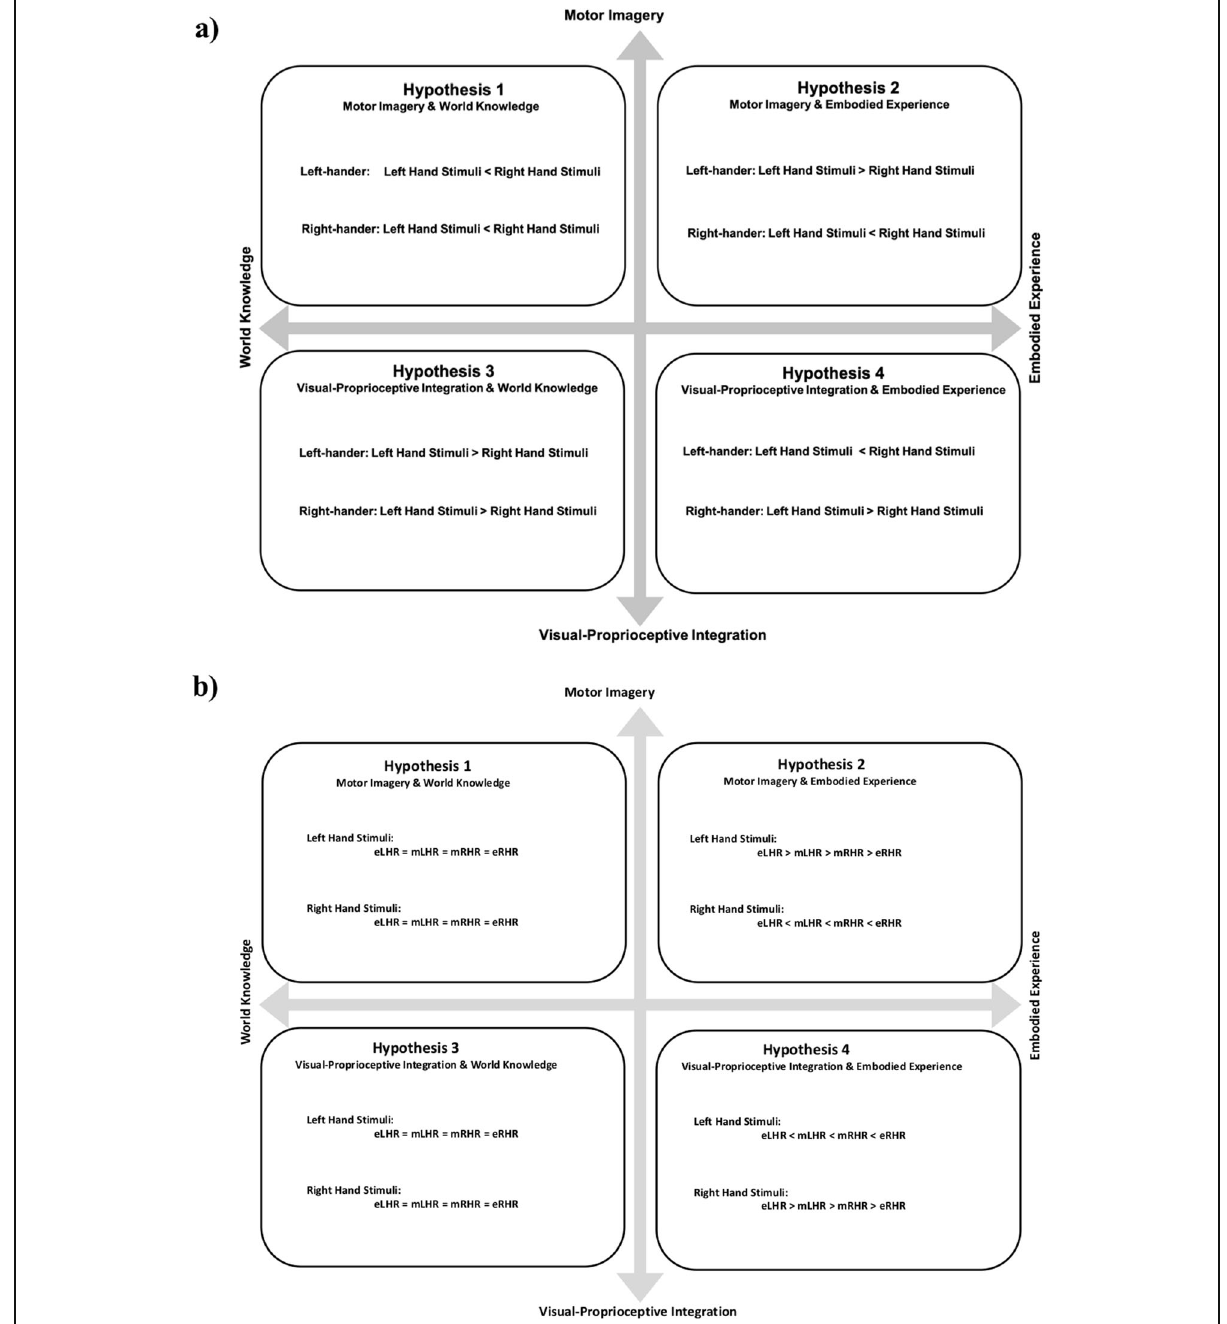
Fig. 1 Hypotheses and predictions. a Predictions based on the subject ’ s handedness, indicating which stimulus will have greater performance for each group. b Predictions based on hand stimuli tested, indicating which handedness group will perform best for left- and right-hand stimuli. eLHR Extreme left-handers, eRHR Extreme right-handers, mLHR Mixed left-handers,, mRHR Mixed